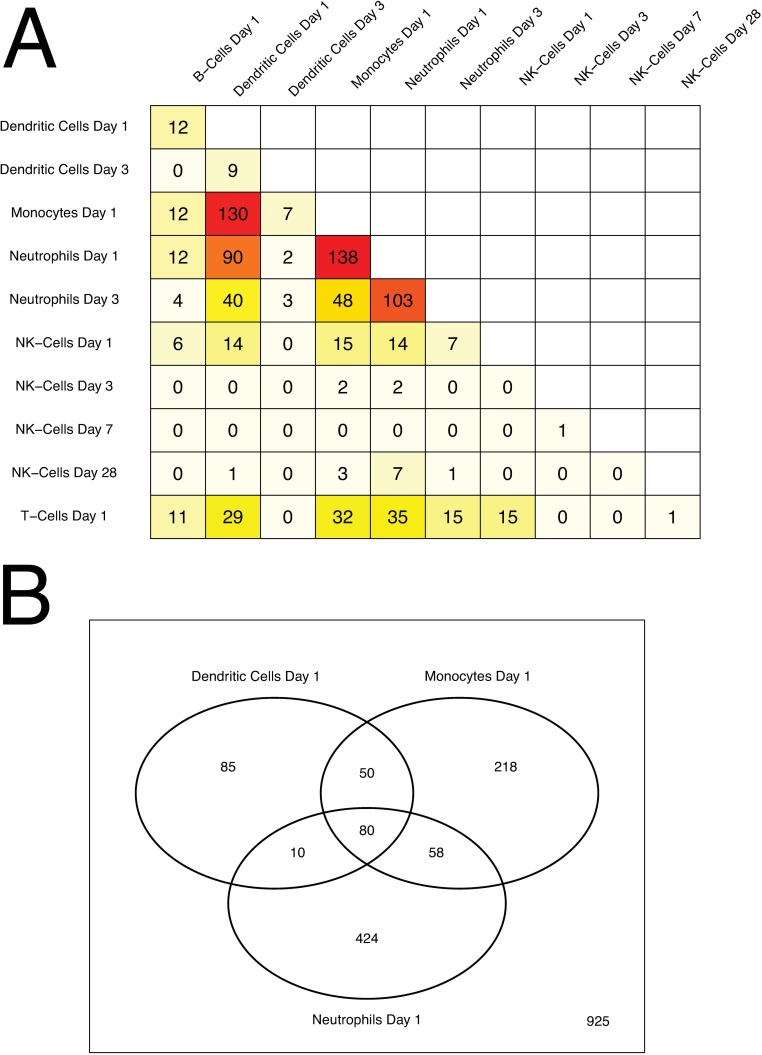
Differential gene overlap between immune cell types.(A) Numbers of overlapping DE genes for each cell type and post-vaccination time point combination. Cells are color-coded by number of overlapping genes (dark-red: high overlap, light-yellow: low overlap). (B) Venn diagram summarizing DE gene overlap between neutrophils, monocytes, and dendritic cells at day 1.